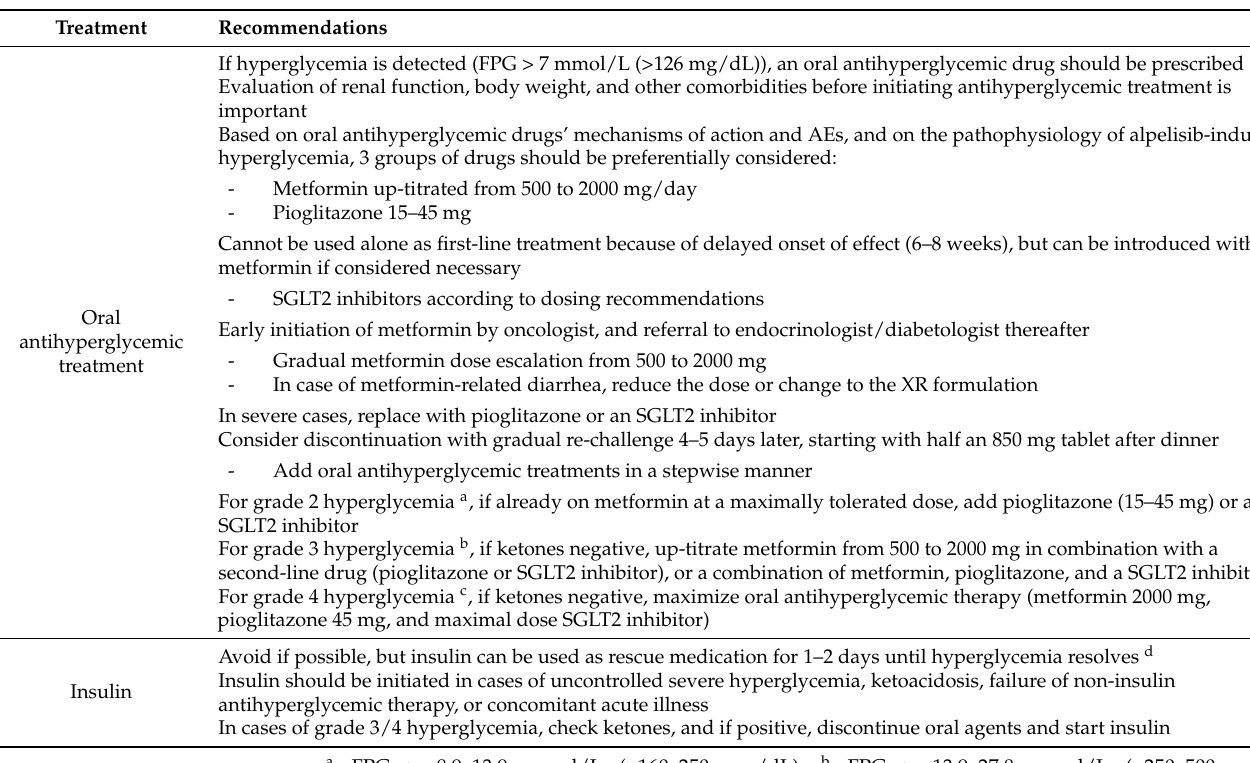
Table 2. Recommendations for the use of antihyperglycemic agents to treat hyperglycemia associated with